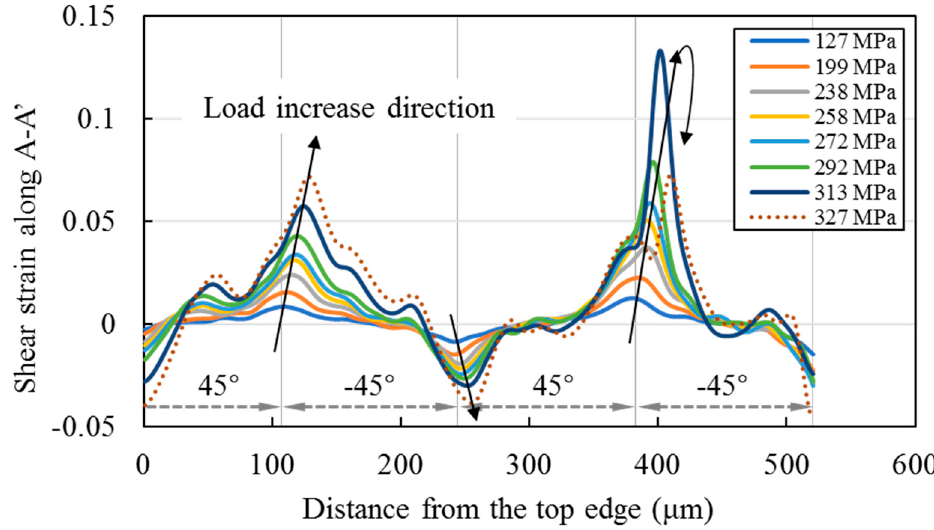
Figure 10. Shear strain of CFRP under different loads along the section line A-A’ labeled in Figure 9a.